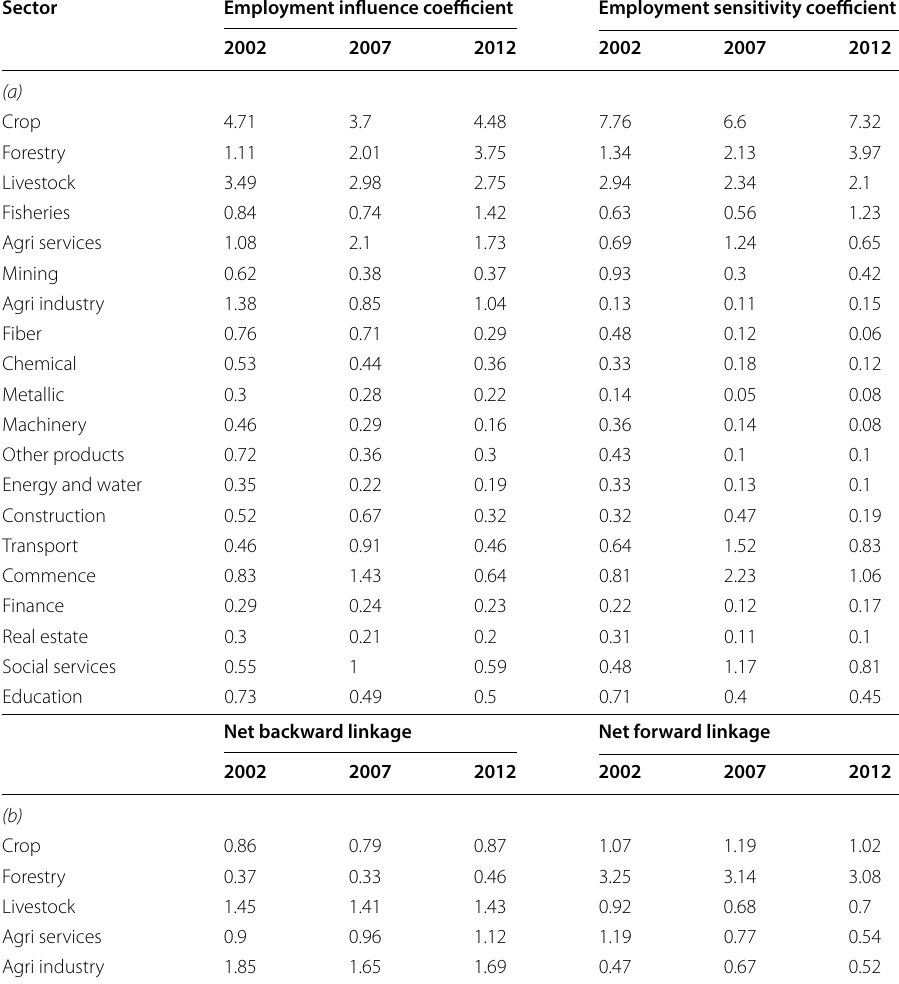
Table 5 (a) Employment influence and sensitivity coefficients in 2002, 2007 and 2012 and (b) the net backward and forward linkages in 2002, 2007 and 2012